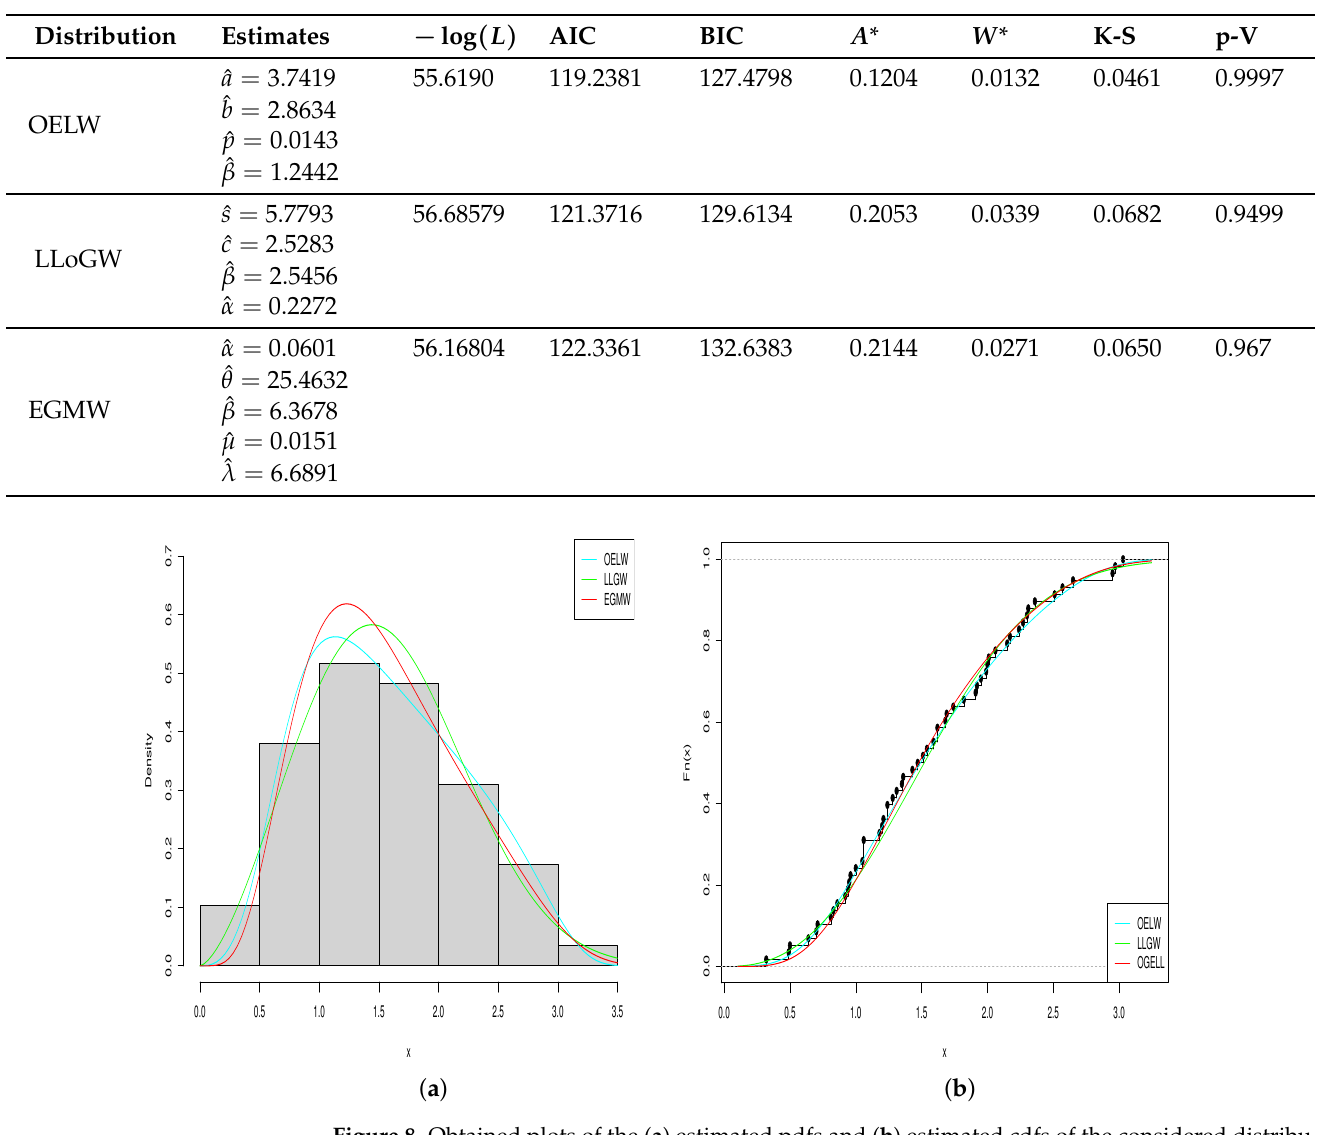
Figure 8. Obtained plots of the ( a ) estimated pdfs and ( b ) estimated cdfs of the considered distribu- tions for the carbon dioxide data